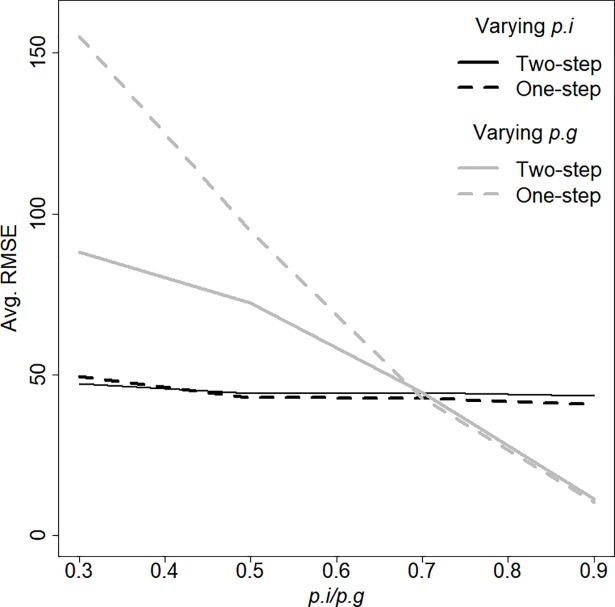
Root mean square error (RMSE) for abundance estimates across 1000 simulated populations for the Two-Step and the One-Step CMR model over a range of group-detection probabilities (pg) and individual-detection probability (pi).When pg was varied, pi was held constant at 0.7, and vice versa.